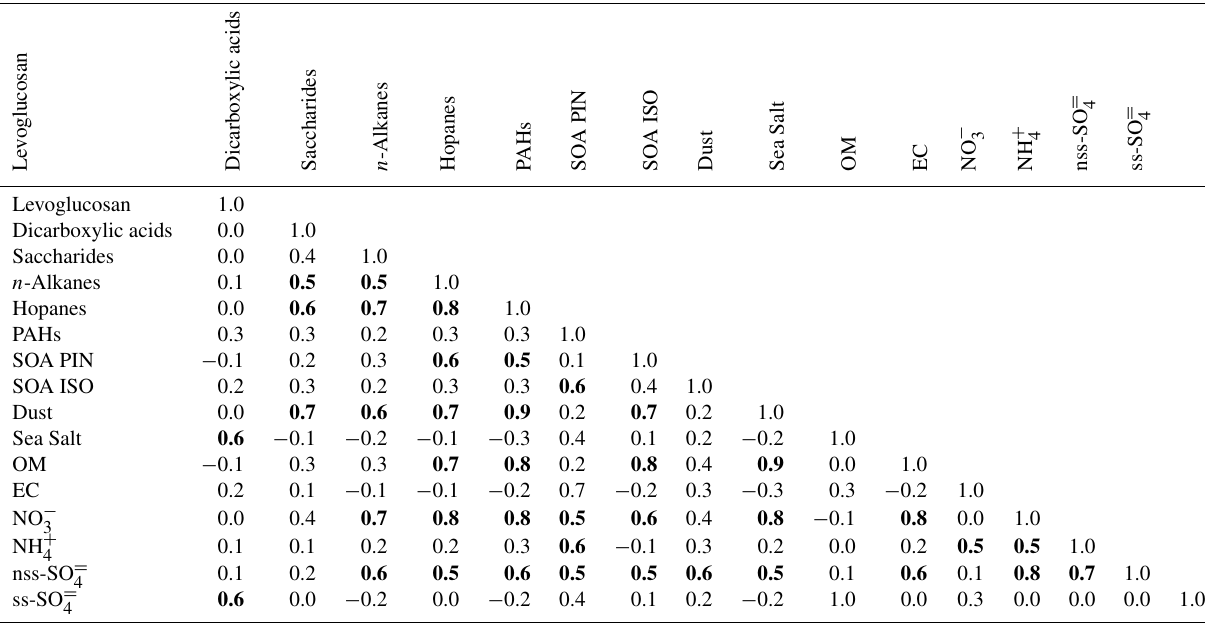
Table 3. Pearson correlation coefficients matrix of the organic and inorganic compounds within the free troposphere (PM T ). Statistically significant correlations ( p value < 0.01) are highlighted. BBE was excluded in this analysis.